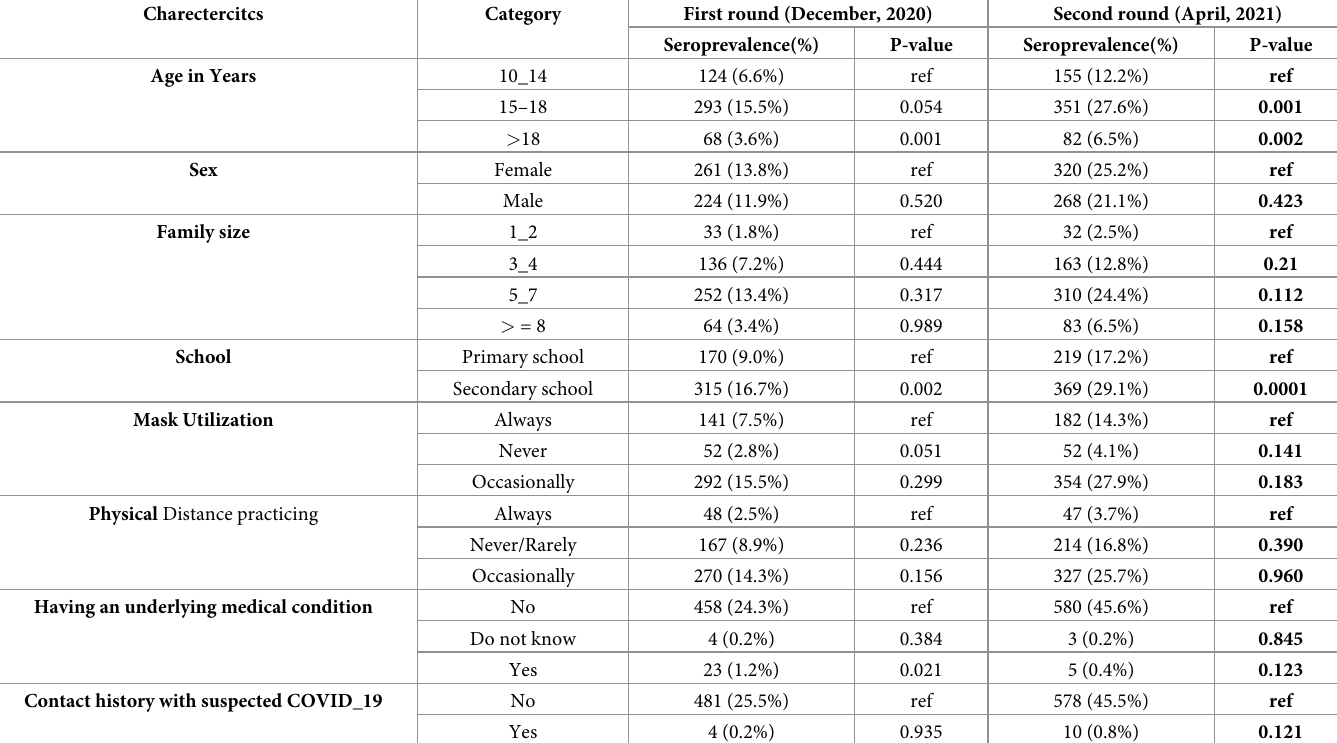
Table 2. Seroprevalence of SARS -CoV-2 (seroprevalence = n/N � 100, N = Total participants and n = SARS-COV-2 positive for IgG, Where N = 1884 and n = 485 for the first round and N = 1721 and n = 588 for second round respectively).